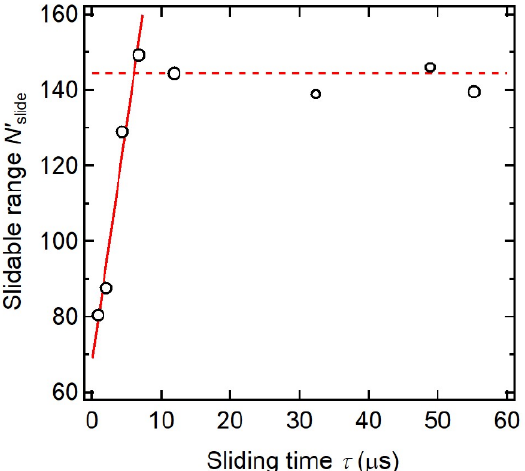
Figure 17. Plot of slidable range N slide of slide-ring cross-links against sliding time τ . Reprinted from [31] with permission from Elsevier.